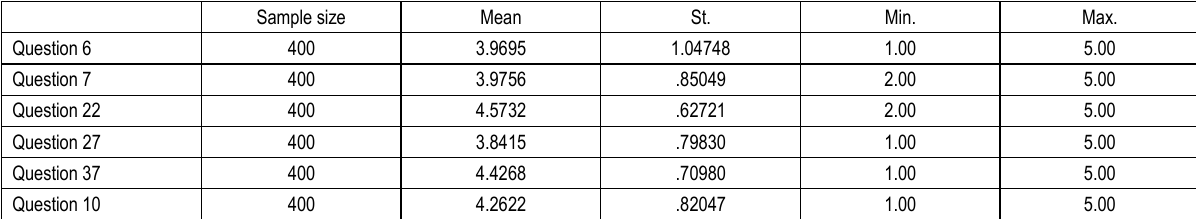
Table 4. Results of descriptive statistics (credit factors)